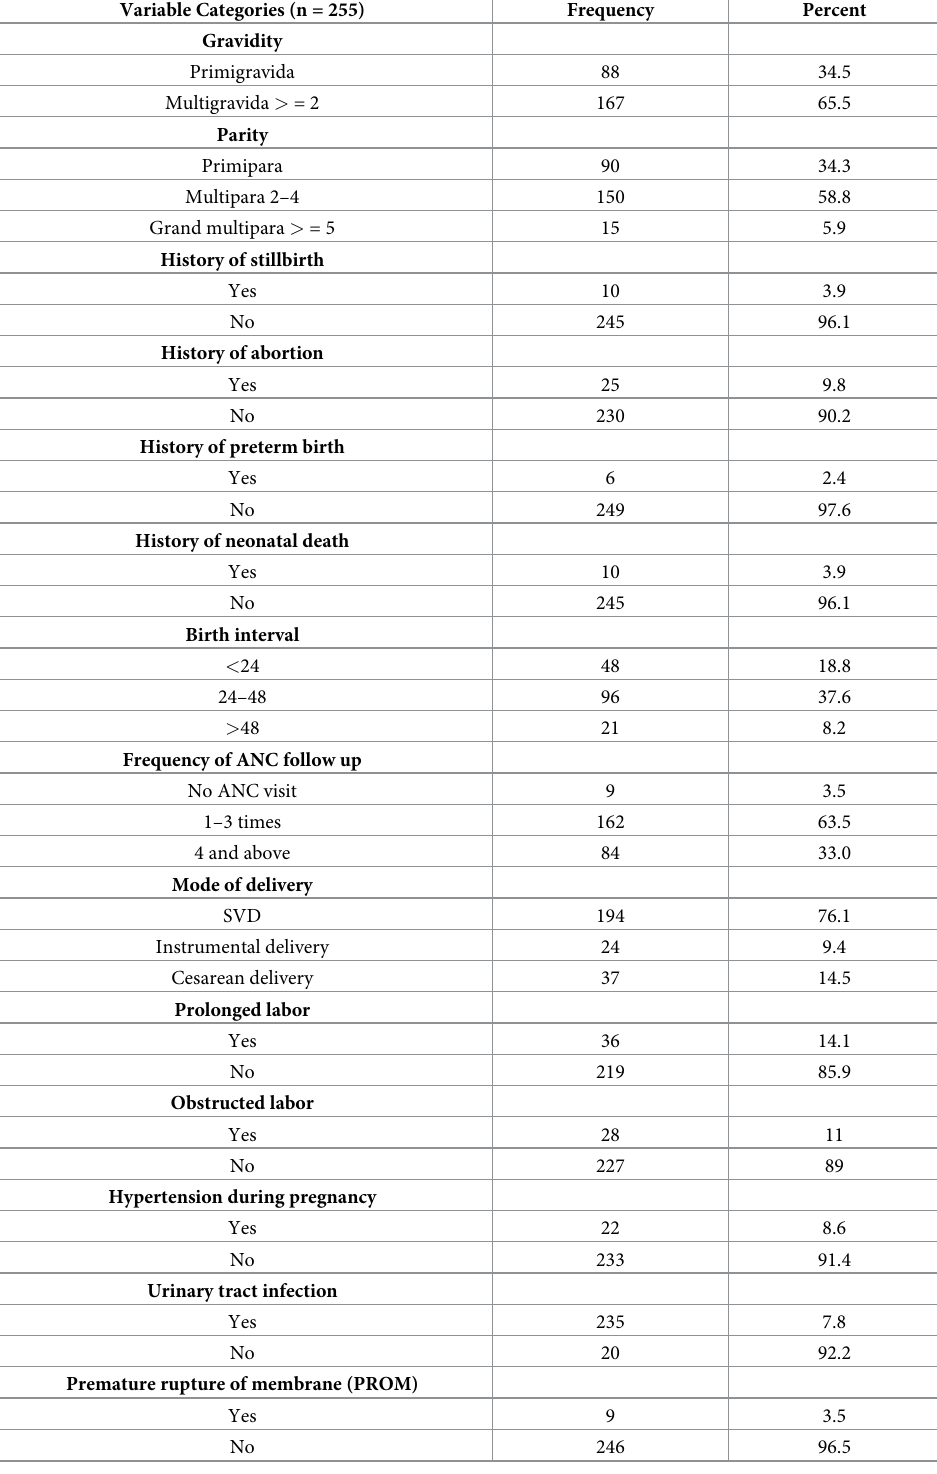
Table 2. Obstetric characteristics of respondents in selected public hospitals of Jimma zone, southwest Ethiopia,